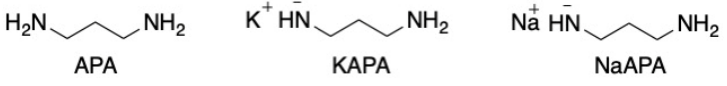
Figure 1. The structure of APA, KAPA and NaAPA.